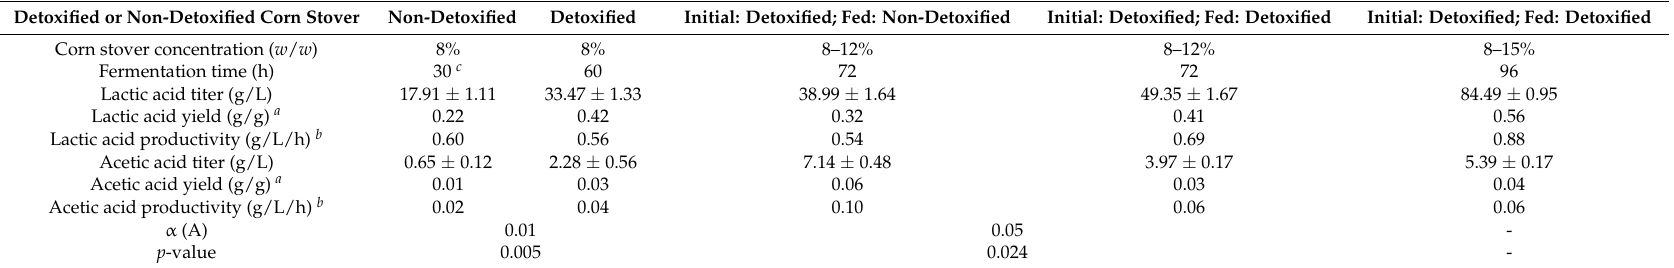
Table 1. Summary of lactic acid production by Bacillus coagulans LA204 using corn stover as carbon source by